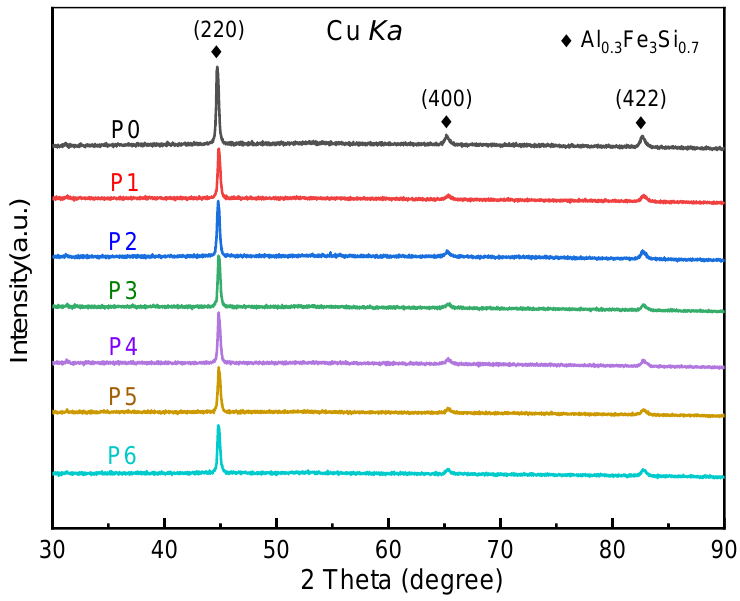
Figure 2. XRD patterns of FeSiAl powders P0~P6. Figure 3 is the particle size distribution of FeSiAl powders. It can be seen from Figure 3 that the powder particle size deviates from the normal distribution with a d 50 of 45.86 μm, exhibiting a generally coarse particle size. As can be seen from the SEM image in the inset of Figure 3, the FeSiAl powders show high sphericity and smooth surfaces.